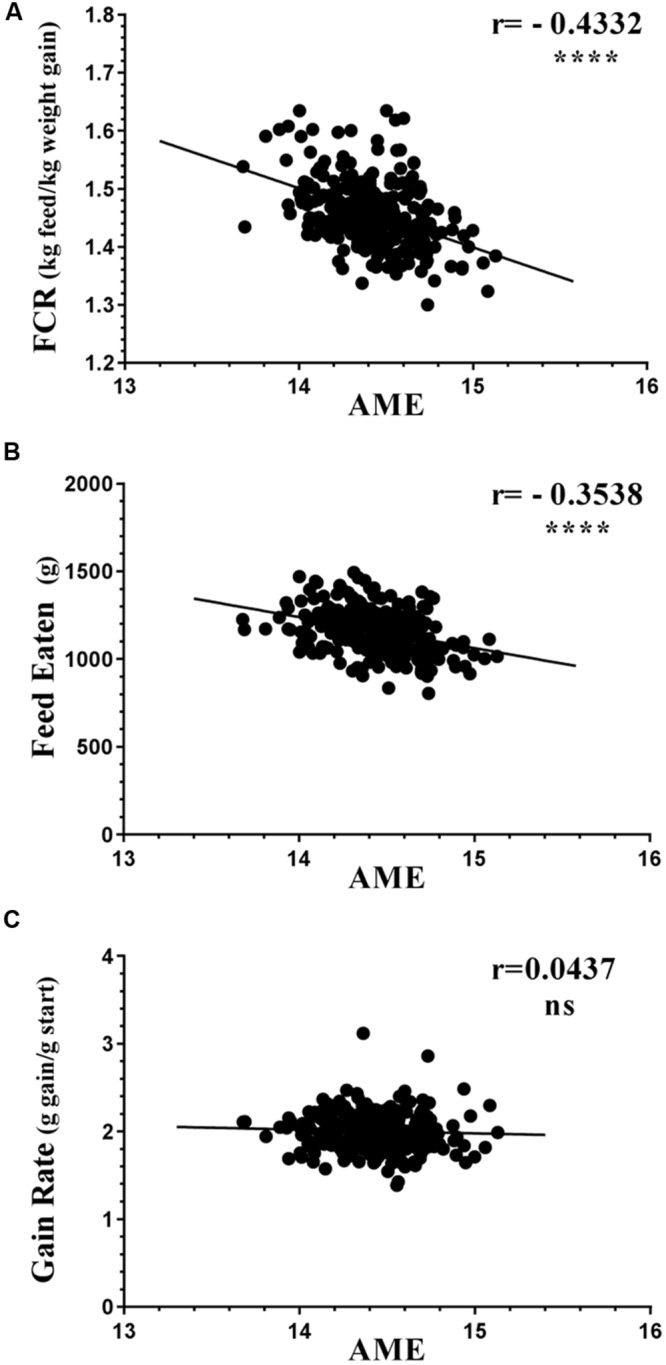
Correlations of AME against (A) FCR, (B) FE, and (C) GR. All birds from all three trials are represented as circles. The birds with higher AME values corresponding to better efficiency in energy extraction are likely to have lower (better) FCR, mostly due to eating less feed while having no change in gain rate (GR). Supplementary Figure S1 shows the same variables separately in each trial; demonstrating that this trend is reproducible.